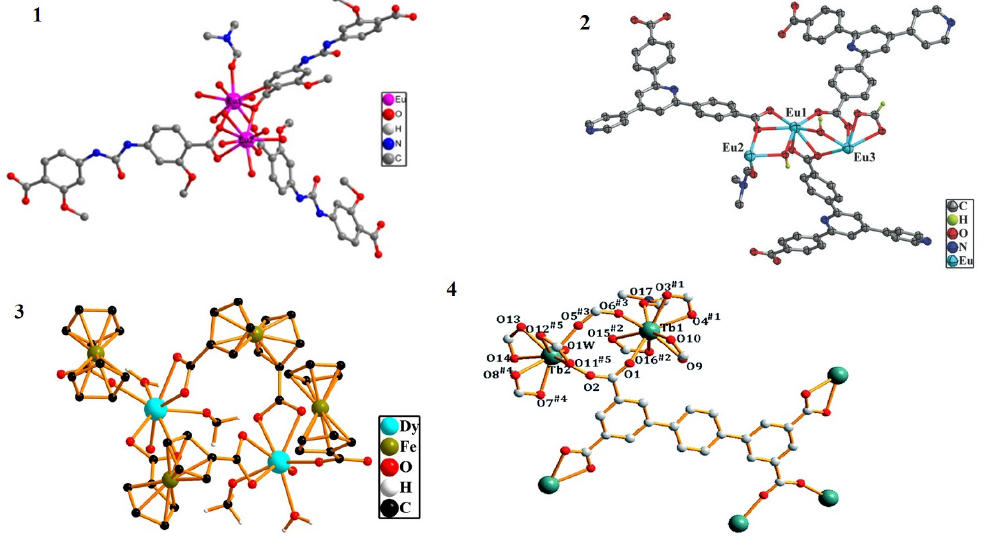
Figure 3. Structures of selected Ln-MOF compounds: ( 1 ) Coordination environment of Eu 3+